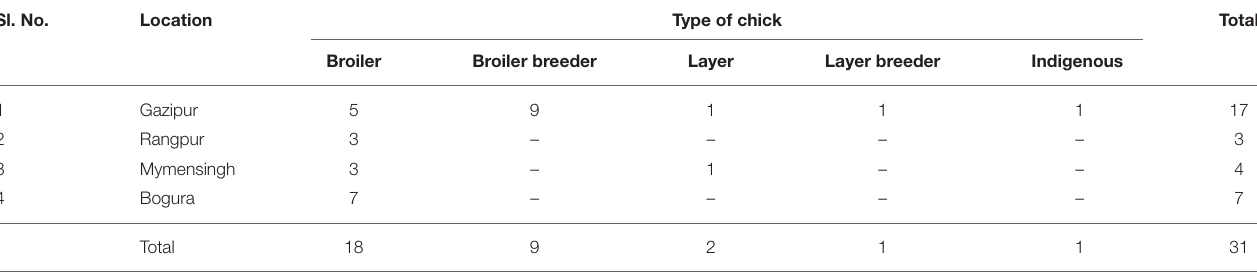
TABLE 1 | Distribution of samples collected from five types of chickens under four areas of Bangladesh (total flock = 31). Sl. No.